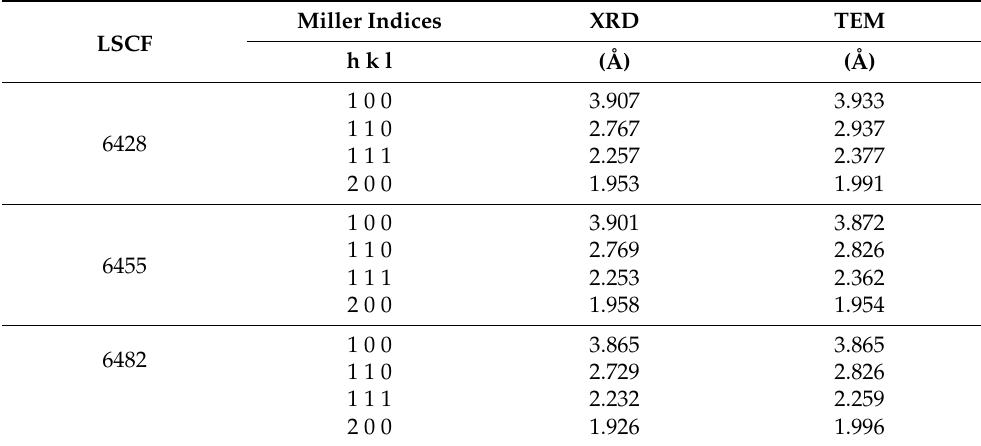
Table 1. Comparison of LSCF d-spacing values obtained by TEM with XRD data. Miller Indices XRD LSCF